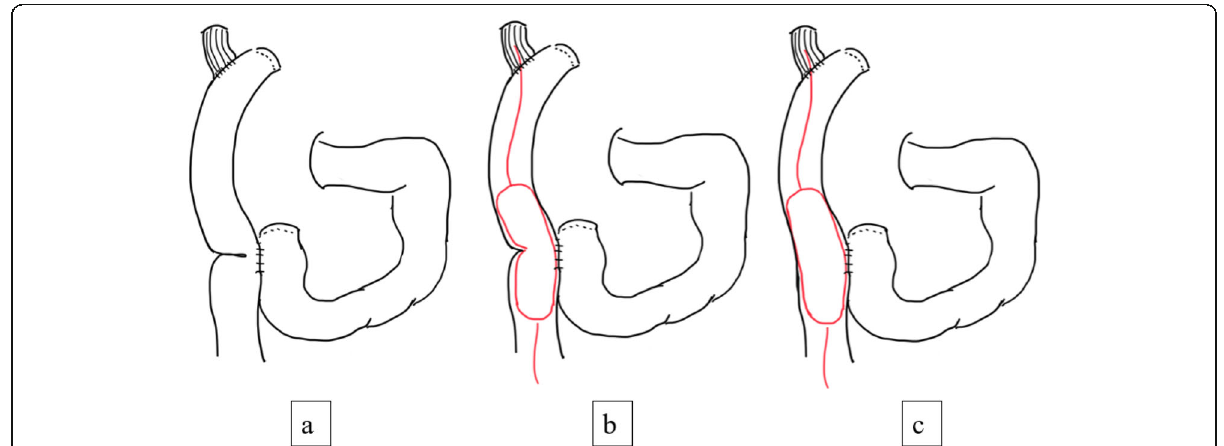
Fig. 3 a , b , c Schema of fluoroscopic balloon